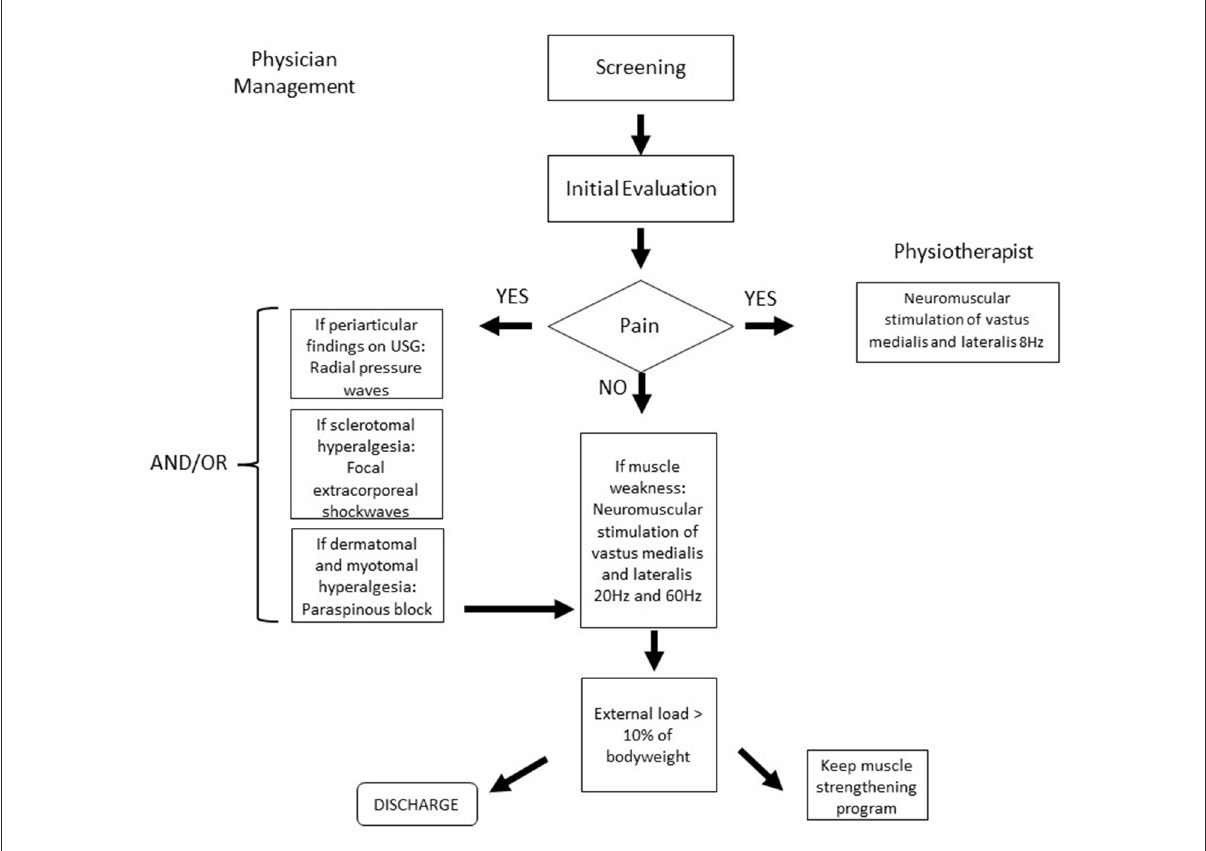
FIGURE2 Intervention decision tree. USG, ultrasound